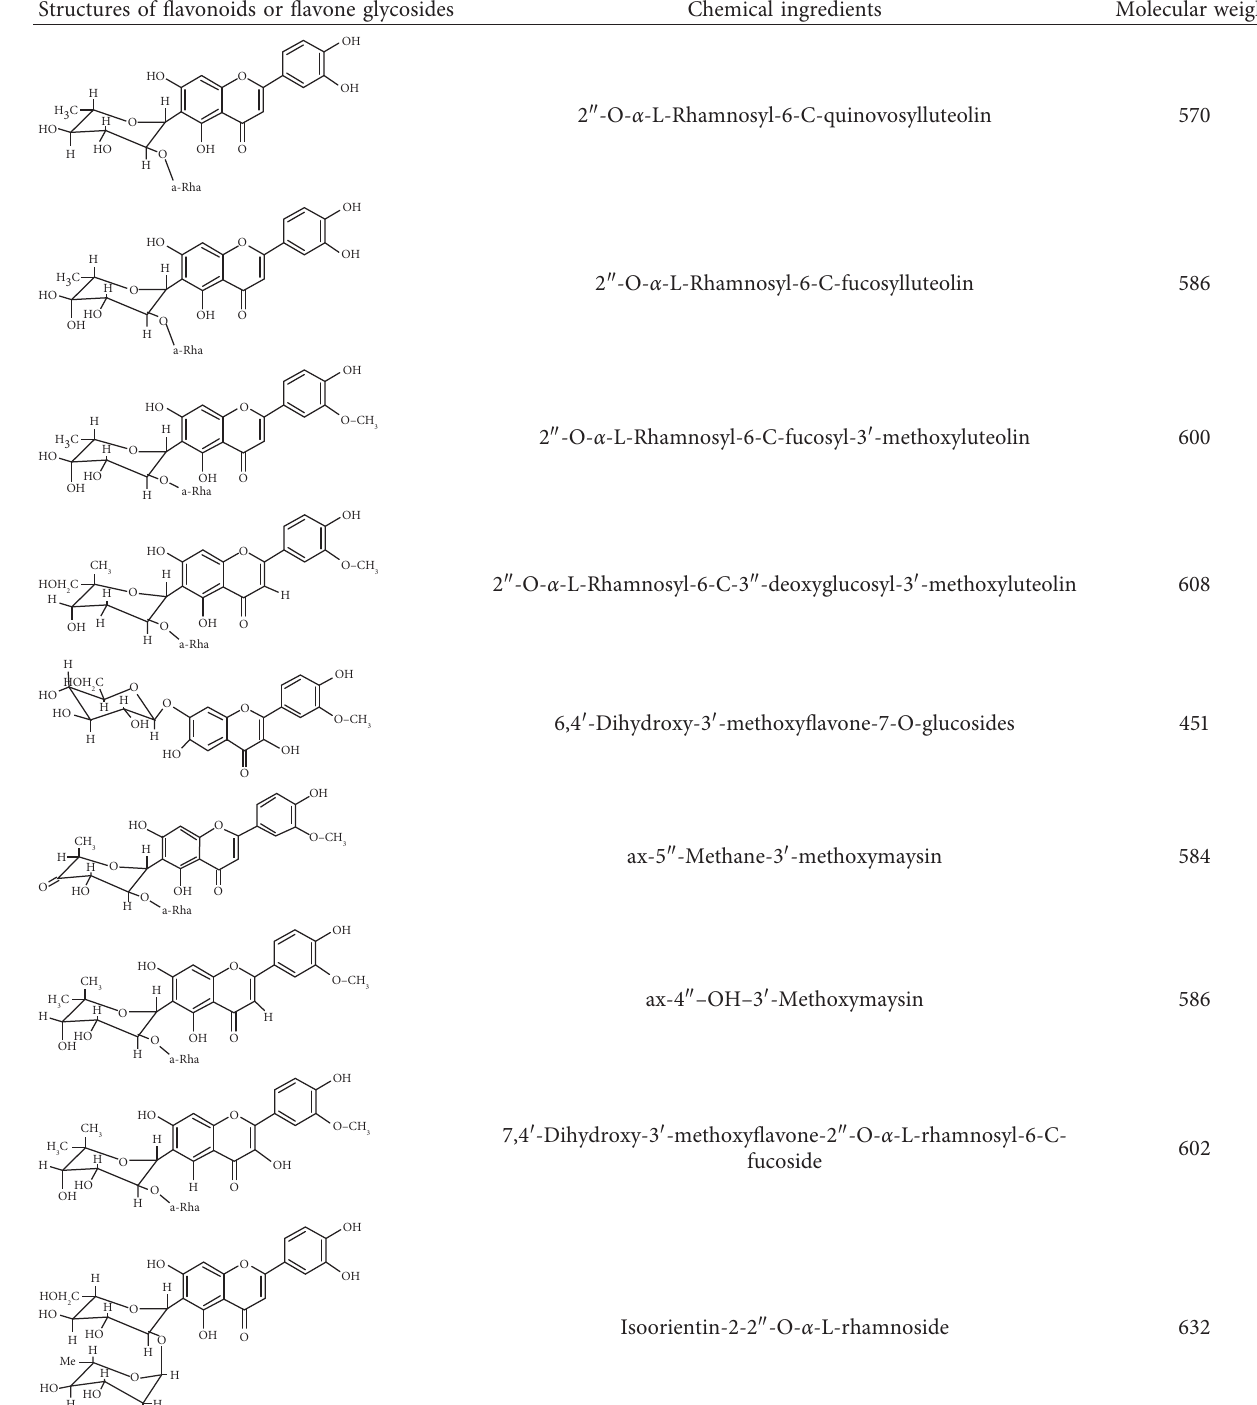
Table 1: Structures and molecular weight of flavonoids or flavone glycosides from corn silk. Structures of flavonoids or flavone